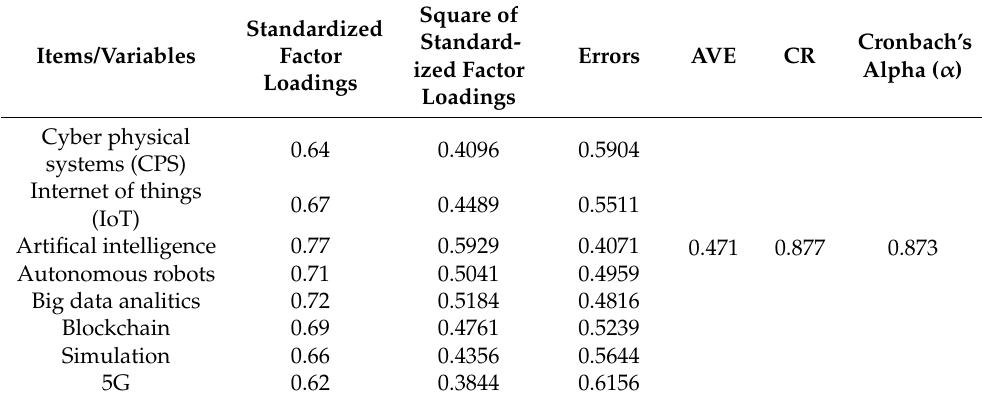
Table 14. AVE, CR and Cronbach’s Alpha Values.